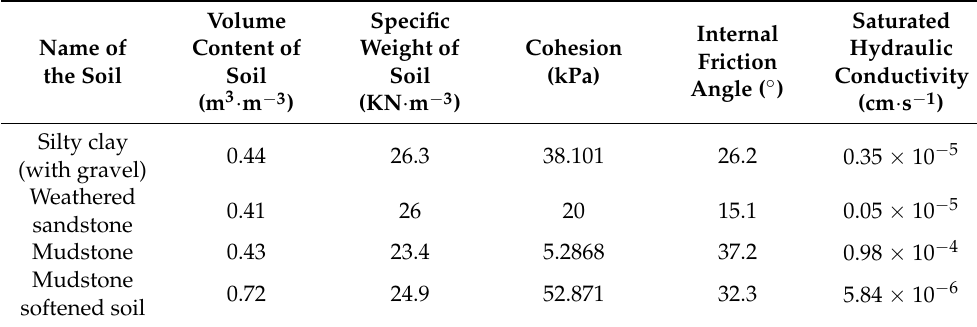
Table 1. Table of calculation parameters.